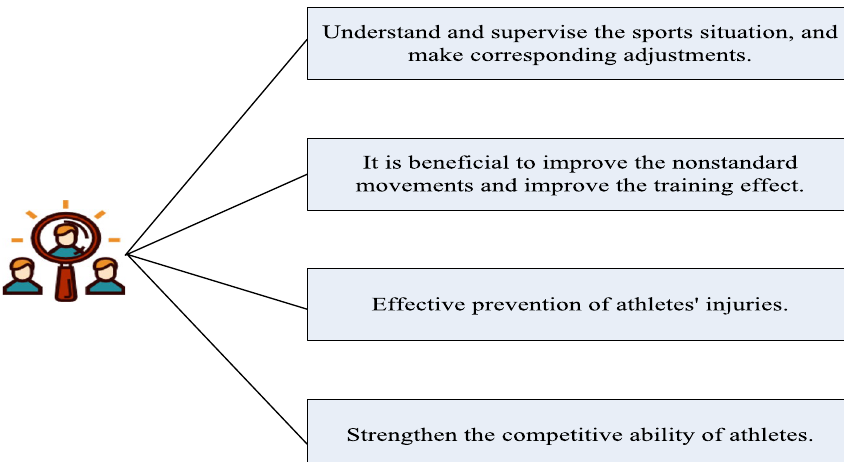
Fig. 3 Advantages of wearables applied to sports competition and training